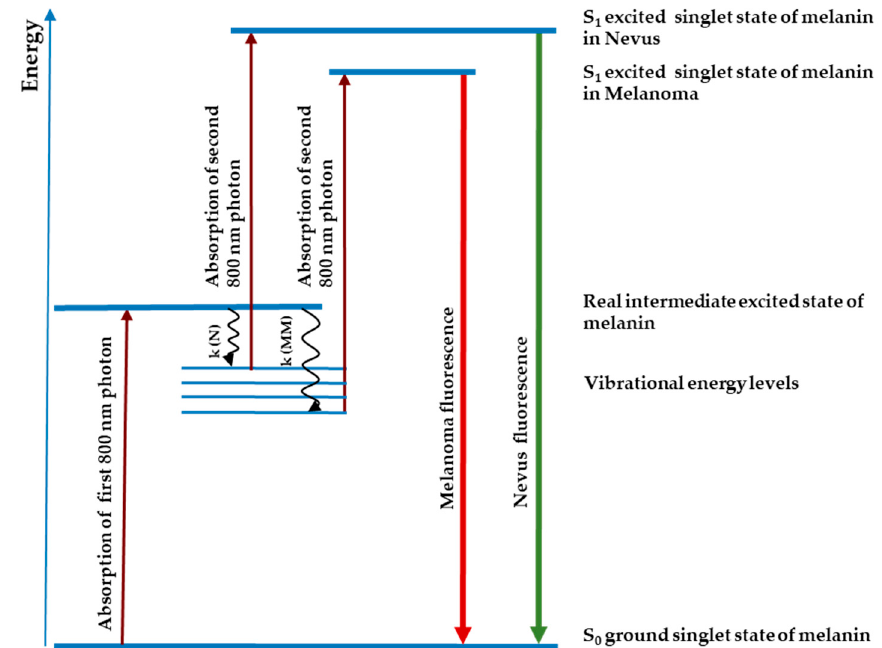
Figure 1. The stepwise two-photon absorption of nanosecond pulses of melanin in nevus and melanoma. The cancer-induced microenvironment alterations lead to different characteristics of the melanin first excited state, such as lifetime and non-radiative energy dissipation rates (k). The wavy lines depict non-radiative decay in nevus (N) and melanoma (MM); the colored lines show the actual bathochromic shift of melanin fluorescence in malignant melanoma compared to fluorescence of benign nevus.